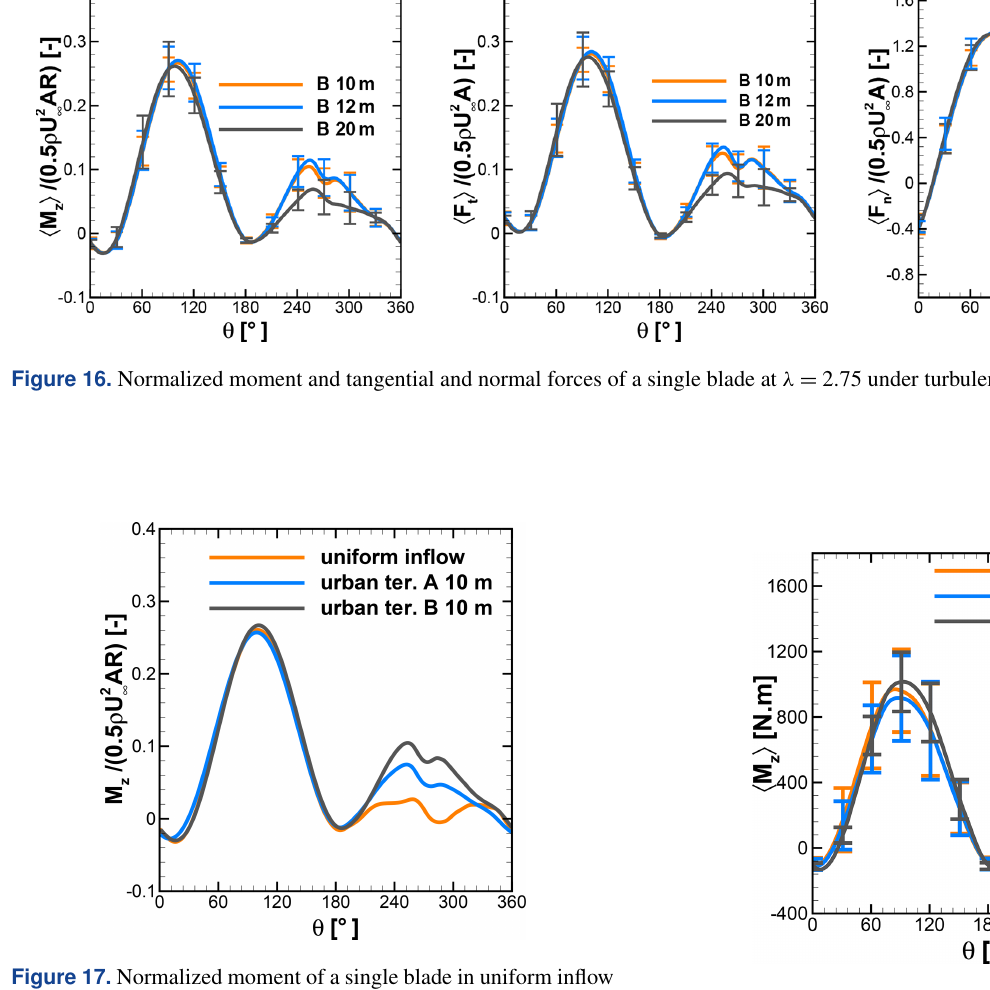
Figure 18. Moment of the complete rotor at different heights over rooftop of